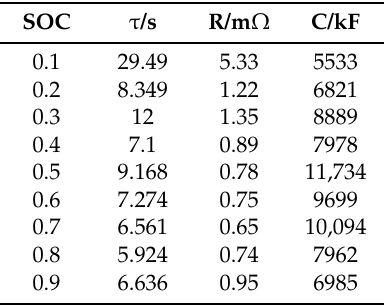
Table 2. Parameter identification results for the Thevenin battery model.